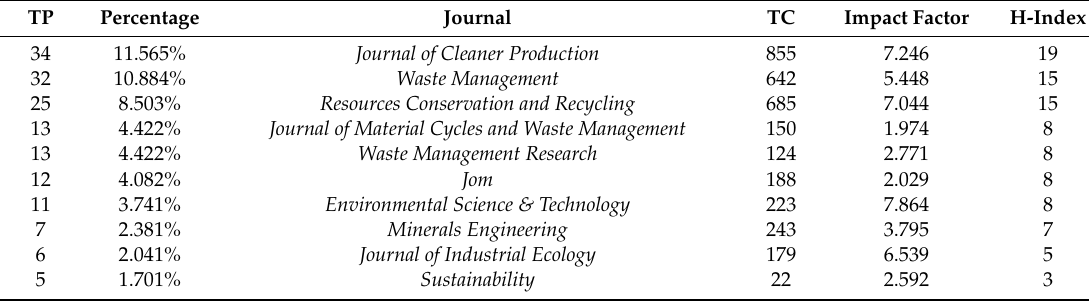
Table 2. The performance of the 10 most leading journals.